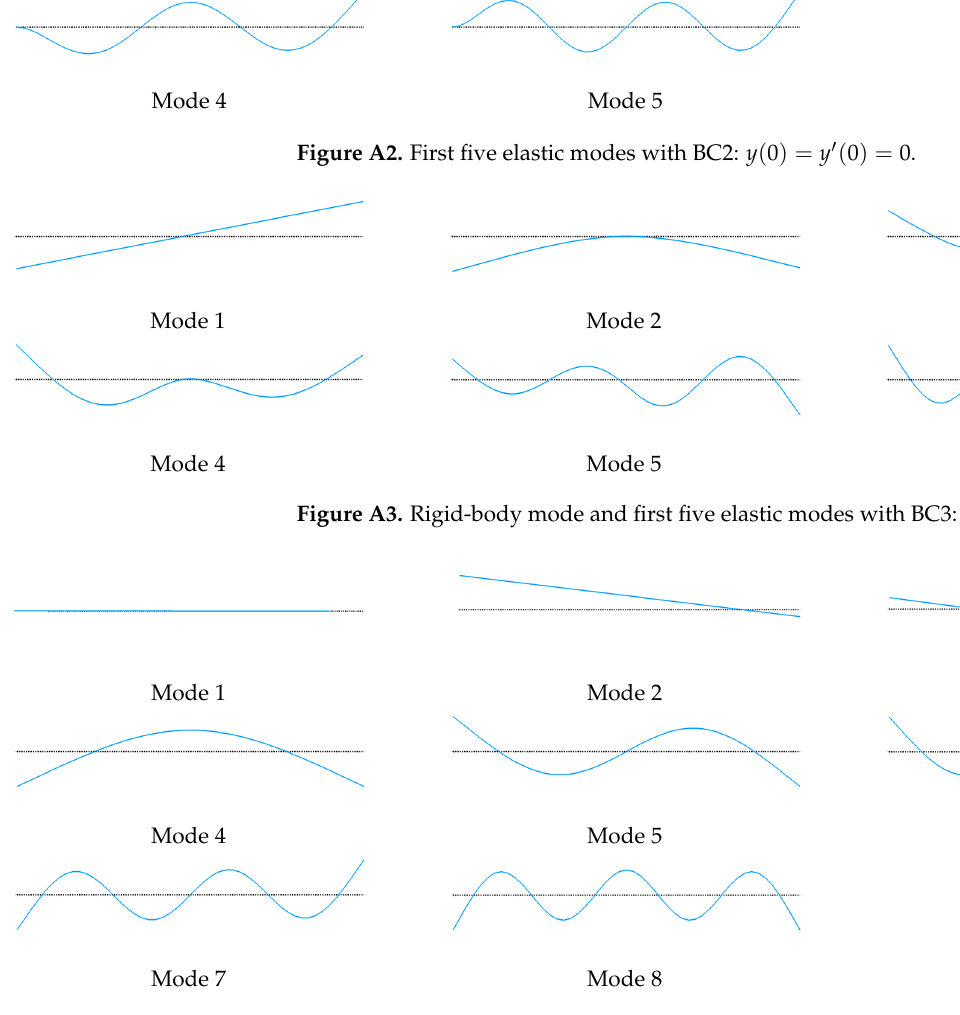
Figure A4. Rigid-body modes and first five elastic modes with BC4: free–free.